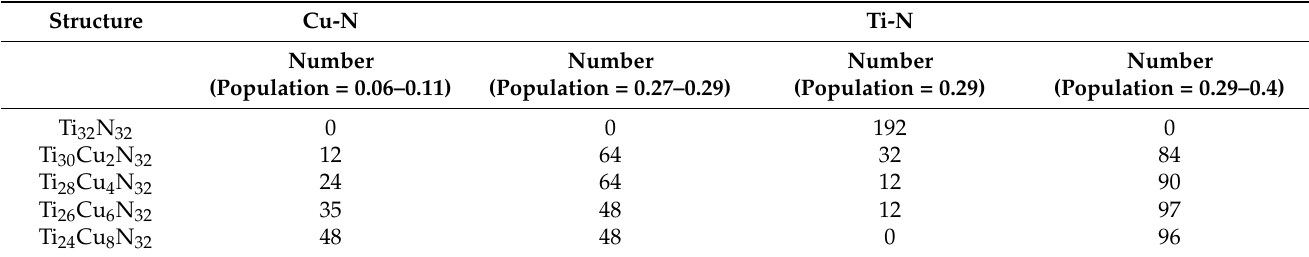
Table 6. Mulliken bond population of TiCuN with different Cu